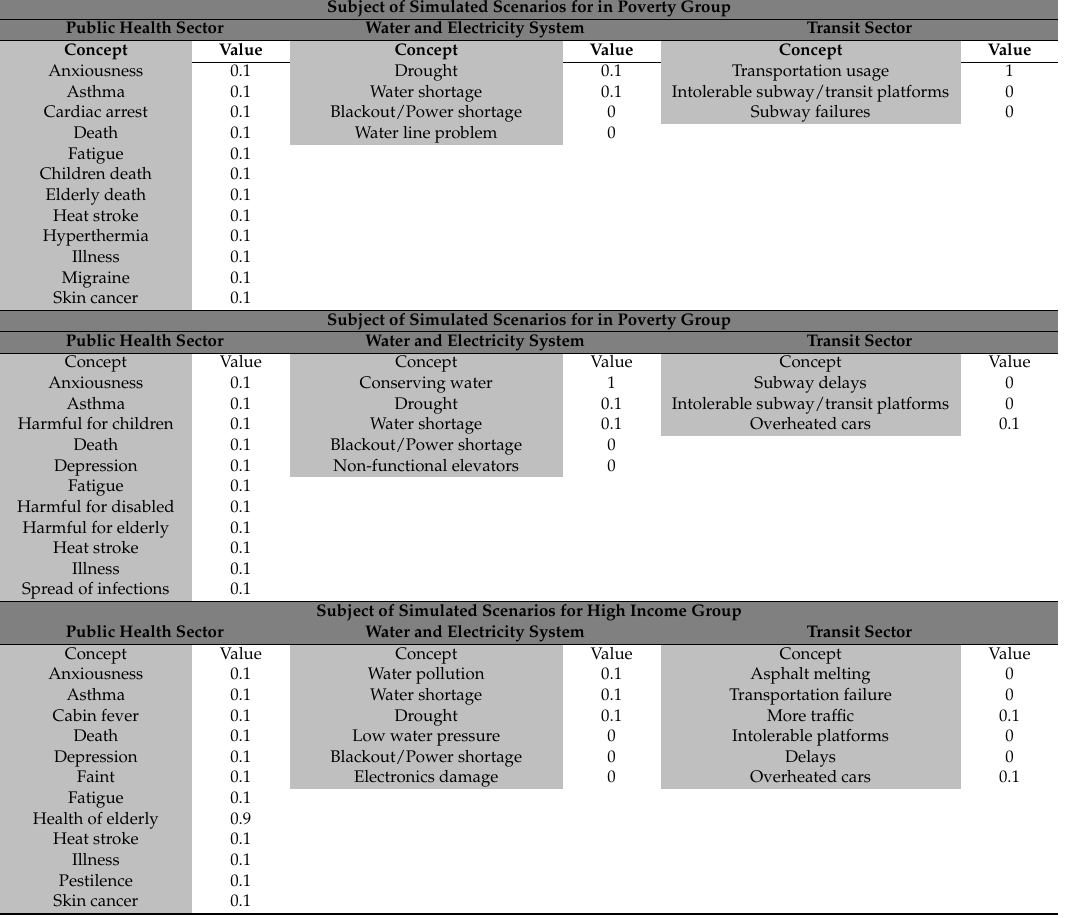
Table A1. Selected concepts and their fixed values for scenario simulation in